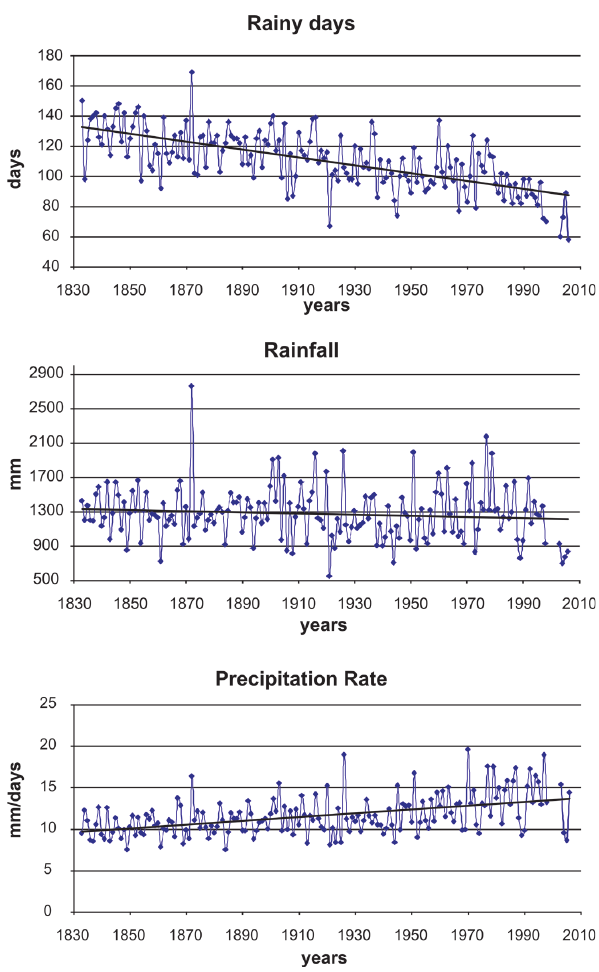
Fig. 6. Rainy days, rainfall and precipitation rate historical trend recorded at Genoa University station in the 1833–2006